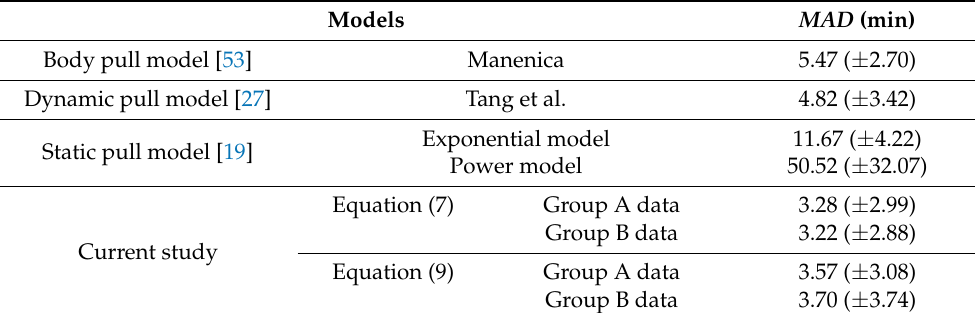
Table 2. MAD values of the predictive